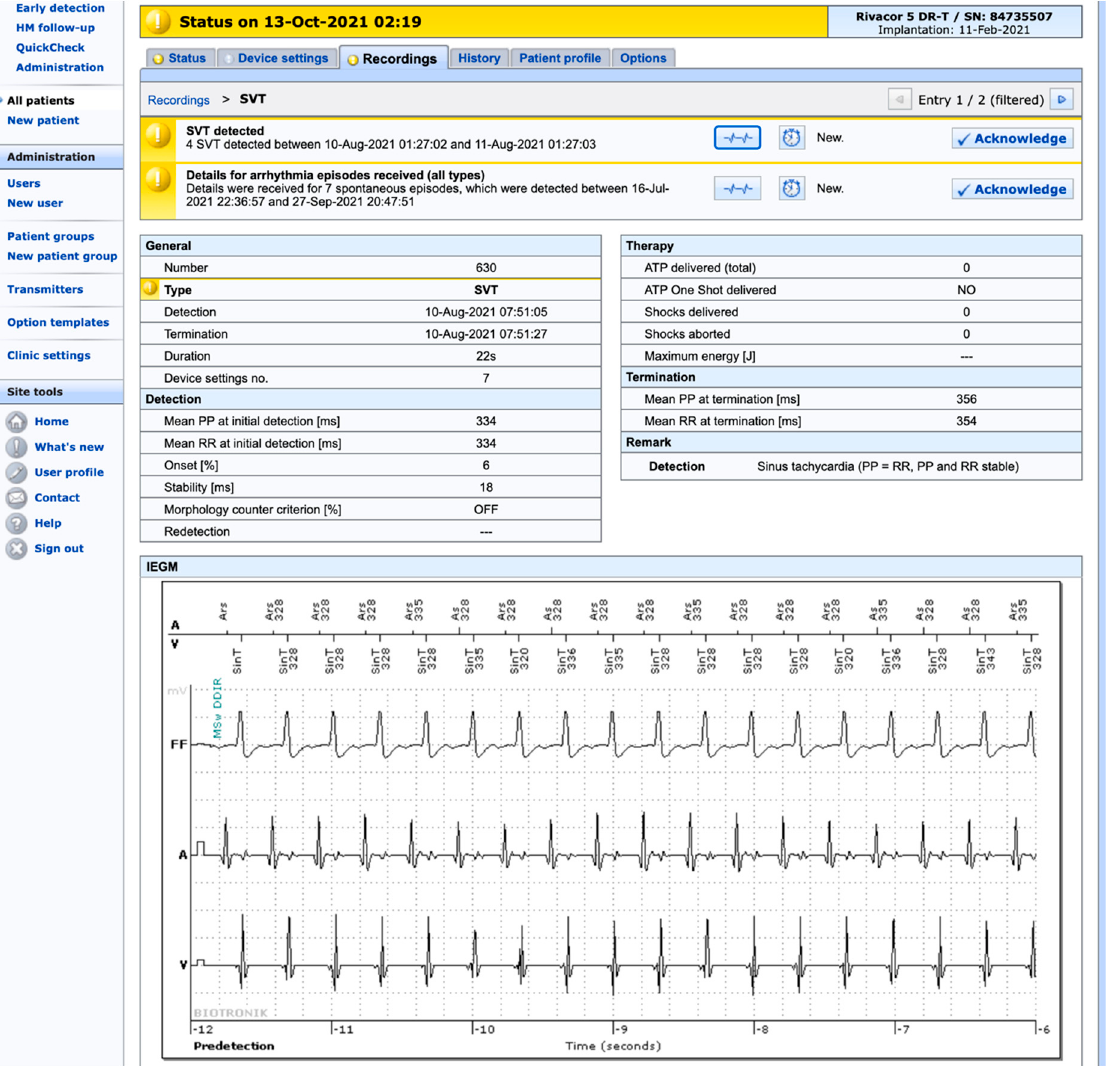
Figure 3. Screenshot from a web page in one of the RM systems (Biotronik Home Monitoring™, Biotronik SE & Co. KG, Berlin, Germany) showing an episode of “yellow alert” involving a supraventricular tachycardia.